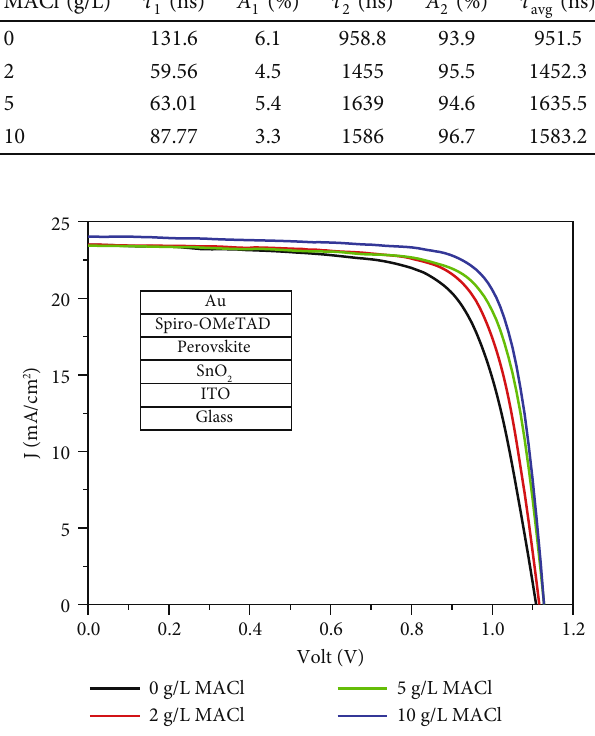
Figure 6: The J-V curves under AM1.5 condition, and the inserted plot shows the device structure of the fabricated perovskite solar cell.